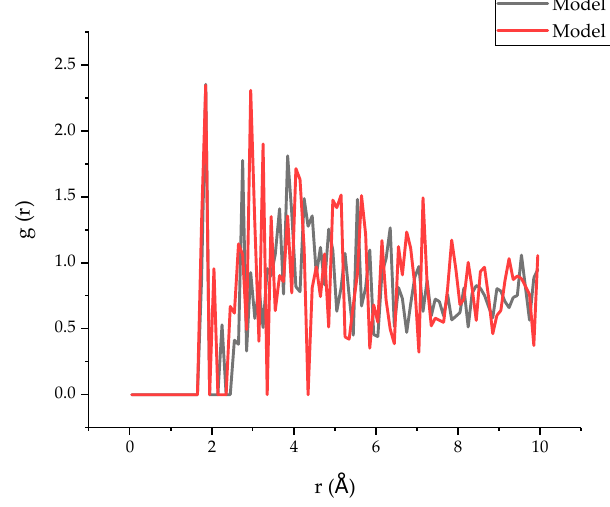
Figure 13. The RDF of H in T and O in epoxy resin.